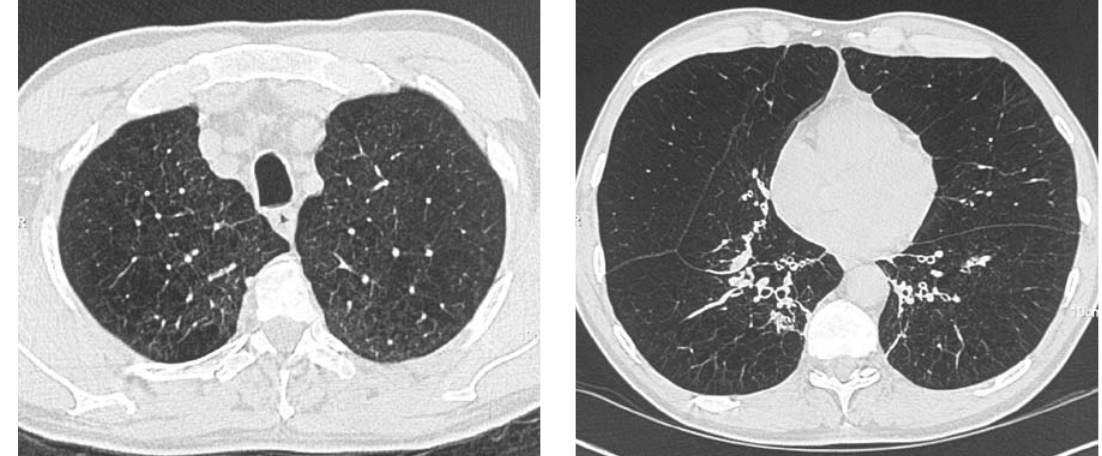
High resolution CT of the lung of a 55- year-old male with PiZZ AAT deficiency. The emphysematous destruction is more prominent in both lower lobes than in the upper lobes. Note the marked bronchial and peribronchial in- flammatory